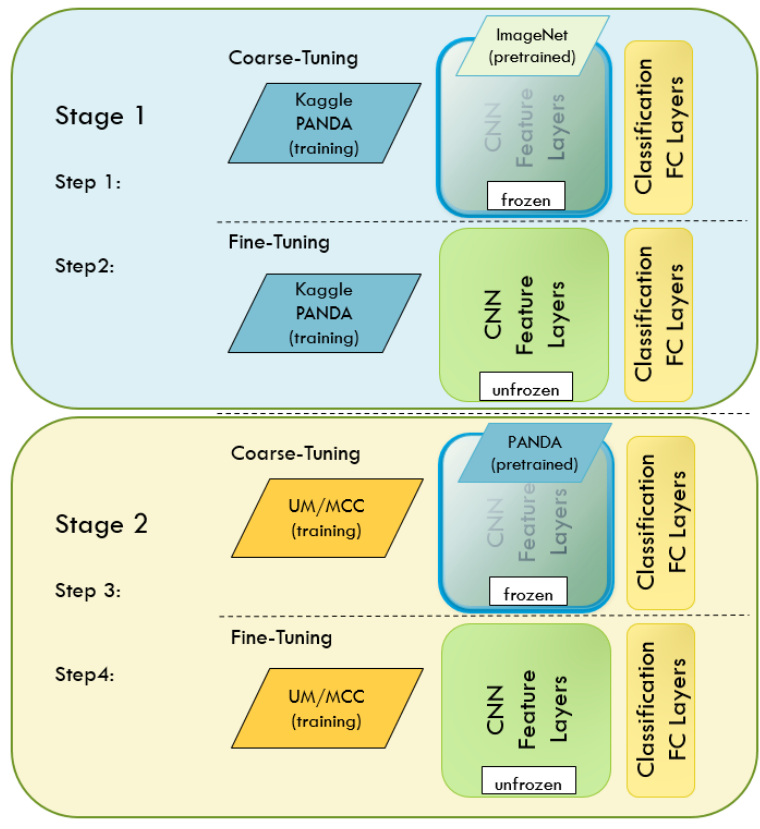
Figure 8. Four steps, transfer learning and fine tuning of NN.